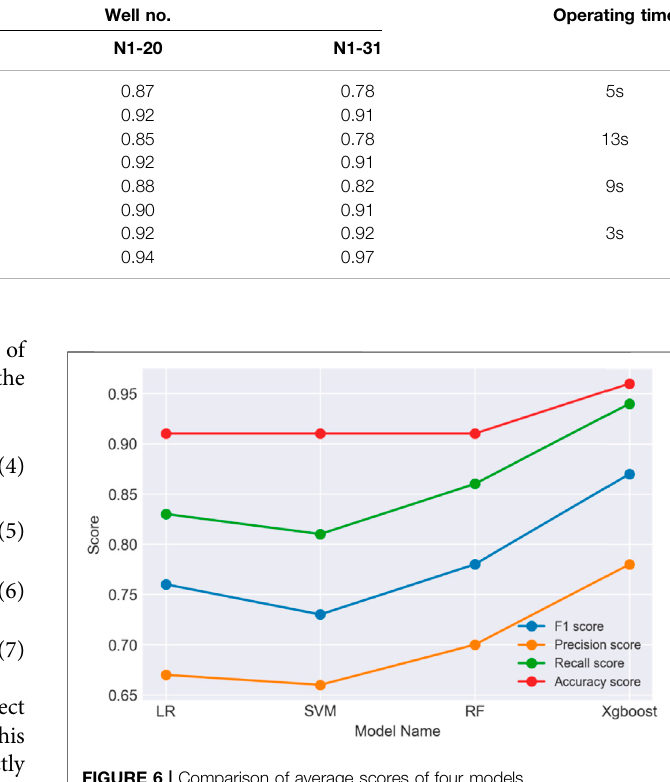
FIGURE 6 | Comparison of average scores of four